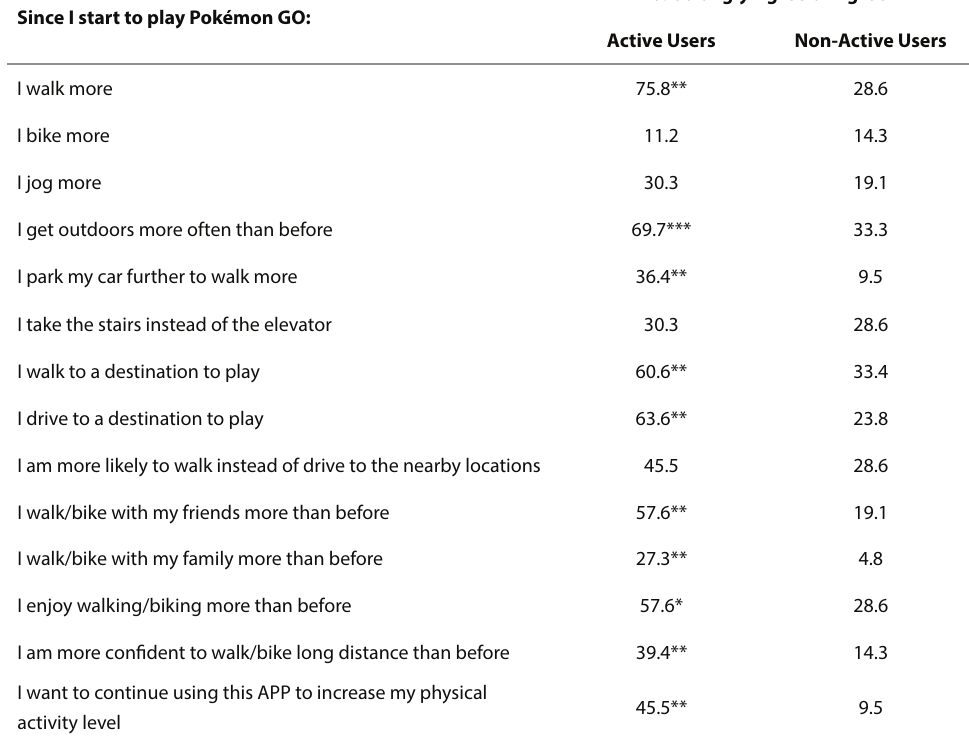
TABLE 2. Perception of Pokémon Go’s Influence on leisure